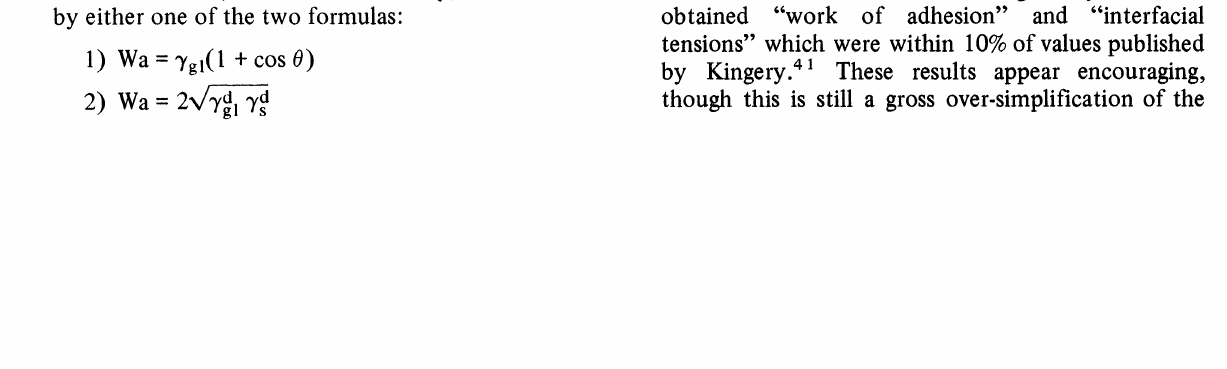
where Wa work of adhesion, 7 total surface energy, the subscripts gl and s mean glass and substrate respectively and the superscript d means dispersion force contribution (in this case to the surface energy). Values of 3 ’d can be derived from contact angle measurements.4 0 Although these equations have been successfully used for non-polar liquids on low energy surfaces, this author has made some trial calculations of metal-glass systems and obtained "work of adhesion" and